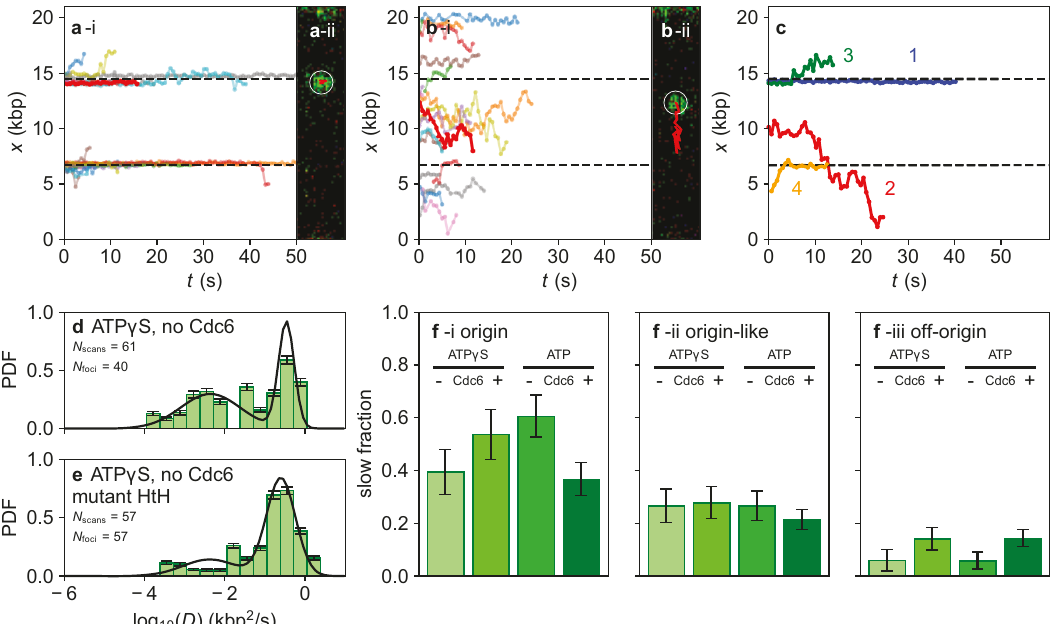
/s)0.0 log 10 ( D ) (kbp 2 Fig. 2 ORC molecules exhibit diffusive motion that is halted at origins. a , b (i) Sample time traces and (ii) scan images that illustrate the observed motion of JF549-ORC initially localized a within 0.2 µ m of the HtH origin or b in any other location. Traces shown represent 3% (randomly selected) of traces from all four biochemical conditions described in Fig. 1. c (i) Sample time traces and (ii) scan images that illustrate the four main types of motion observed for JF549-ORC: (1) static; (2) diffusive; (3) static and then diffusive; (4) diffusive and then static. d Histogram of the diffusion constants of ORC incubated in the presence of ATP γ S. Only foci containing 1 or 2 ORC were considered. The two populations of diffusion constants fi t to log-normal distributions (solid black lines), taking into account the error bars derived from bootstrapping the data set 100 times. This yields populations with mean ± SEM of 0.06 ± 0.04 kbp 2 s − 1 (59% of the distribution) and 0.97 ± 0.09 kbp 2 s − 1 ( p < 0.0001 by one-way ANOVA). e As in d , except that the DNA contains the mHtH origin described in Supplementary Fig. 7. Here, fi tting yields populations with mean ± SEM 0.05 ± 0.03 kbp 2 s − 1 (26%) and 0.88 ± 0.09 kbp 2 s − 1 ( p < 0.0001 by one-way ANOVA). f Quanti fi cation of the percent of ORC molecules initially bound in a given location, which go on to display slow diffusion: (i) ORC molecules initially bound within 0.2 µ m of the HtH origin; (ii) ORC molecules initially bound within 0.2 µ m of origin-like sequences; (iii) ORC molecules initially bound elsewhere. Error bars represent the error of sample proportion, sqrt( p (1 − p)/ n ), where p is the proportion of a sample in a given population, and n is the sample